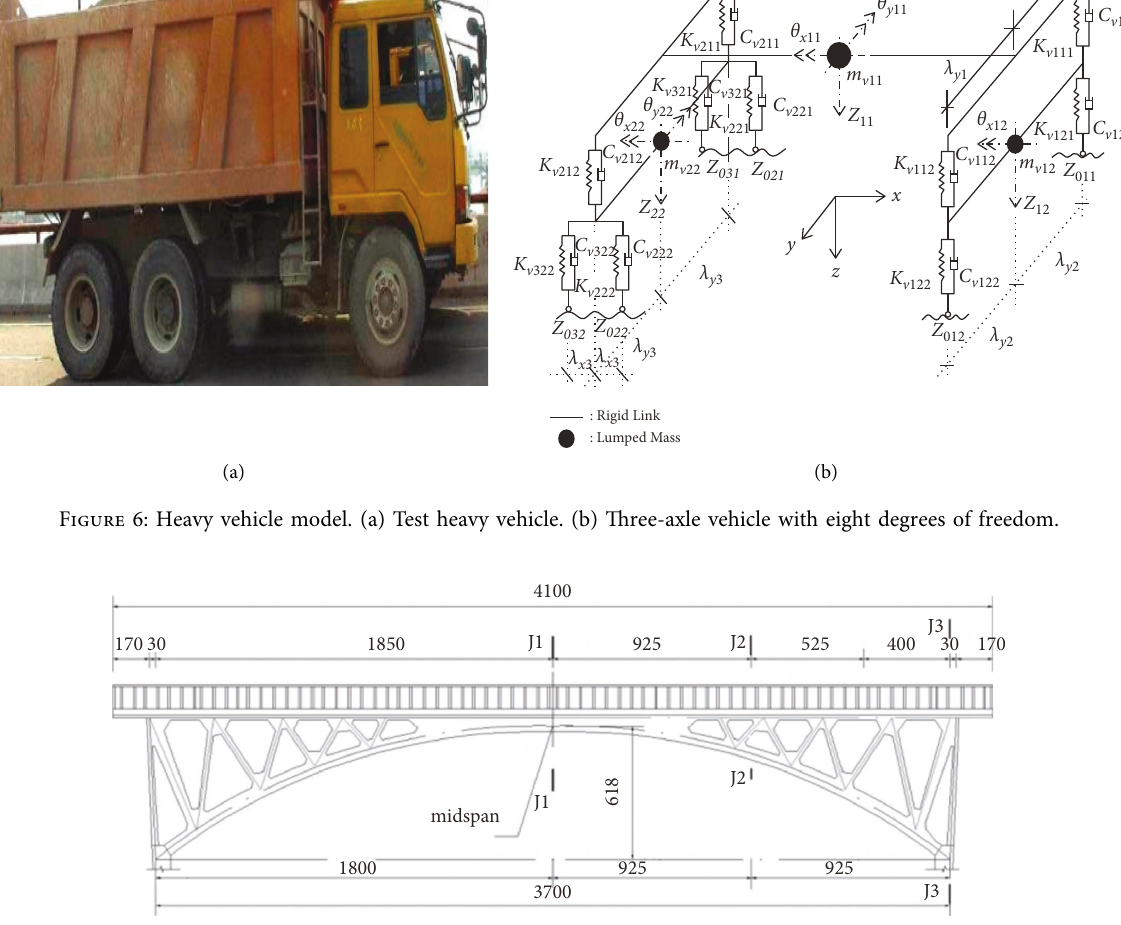
Figure 7: Position chart of the control section.